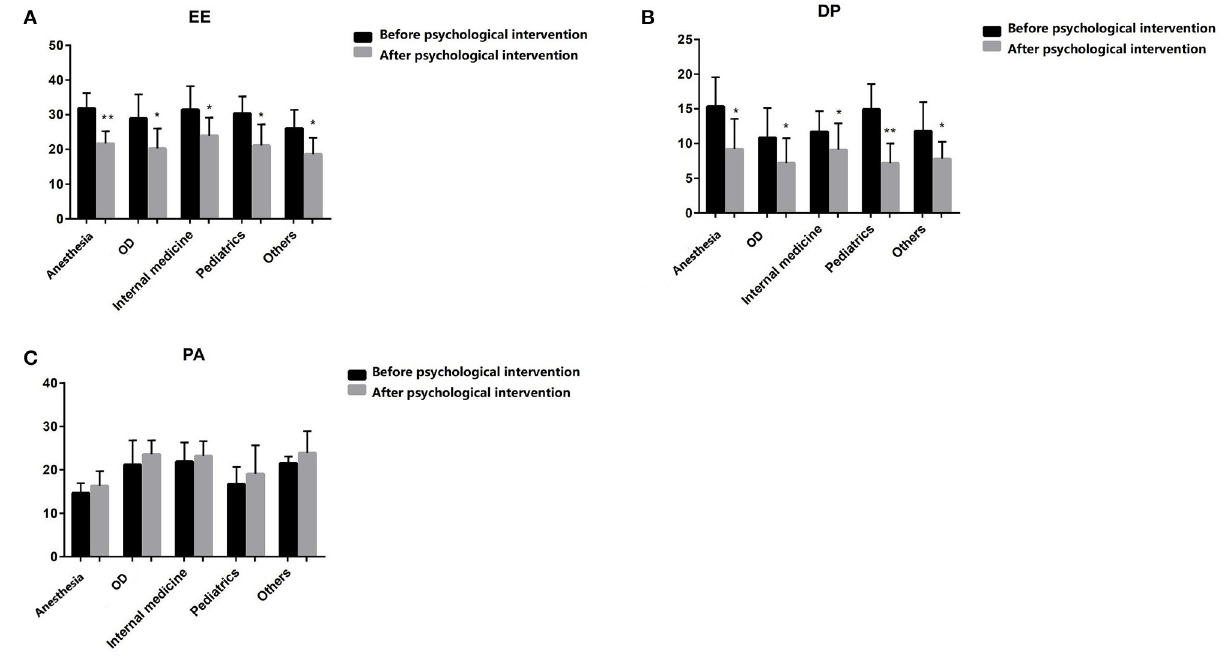
FIGURE 3 | The comparision of MBI before and after psychological intervention among medical students from different majors. The MBI-Human Services version consists of 22 items with three subscales: emotional exhaustion (EE), depersonalization (DP), and personal accomplishment (PA). (A) Emotional exhaustion (EE) of MBI; (B) Depersonalization (DP) of MBI; (C) Personal accomplishment (PA) of MBI. * P < 0.05, ** P < 0.001. OD, Operation